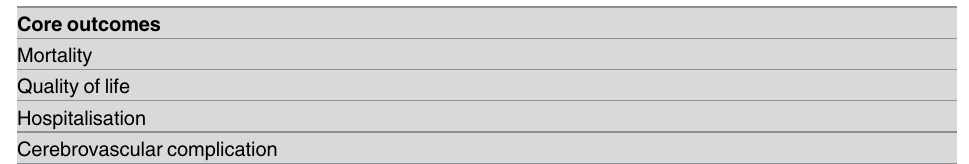
Table 2. Final “COS Adult Cardiac